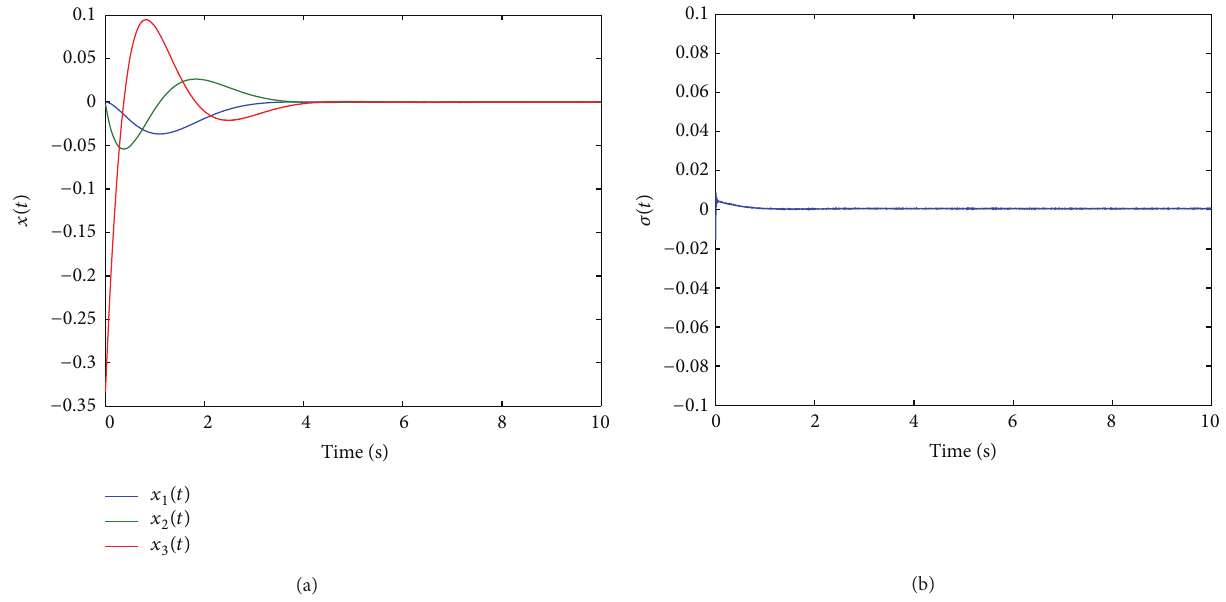
Figure 3: (a) States responses with TPAISMC. (b) Sliding surface function with TPAISMC.